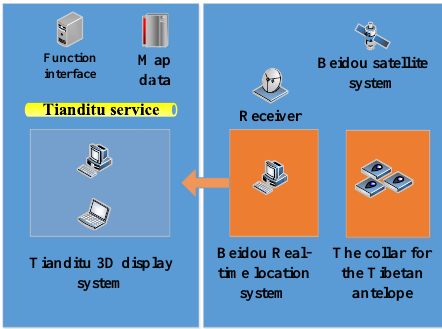
Figure 1: System overall